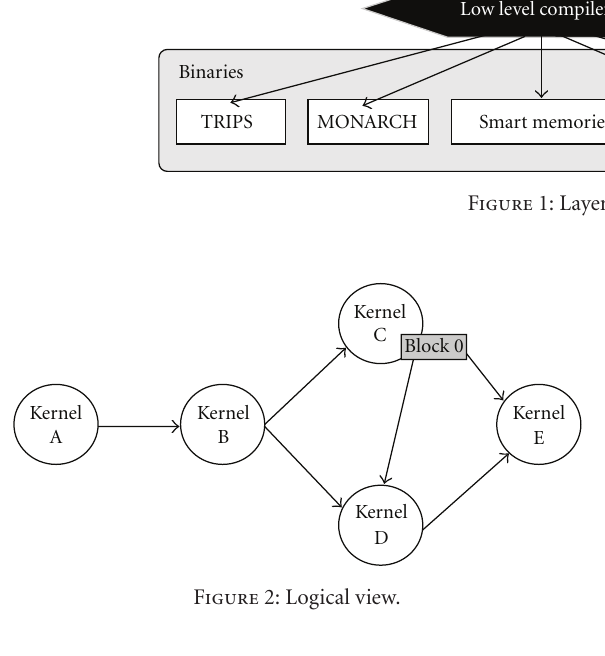
Figure 2: Logical view.